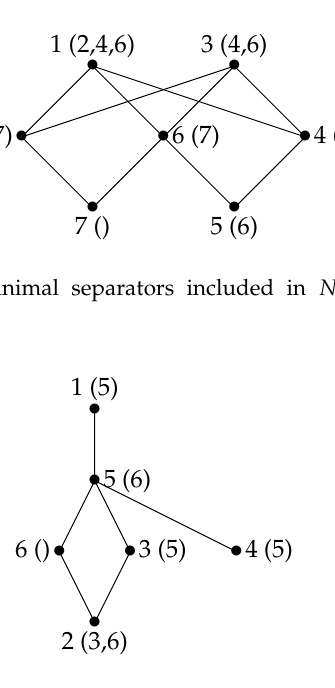
Figure 6. LexDFS does not number the connected components of G ( V \ N [ α ( 1 )]) one after